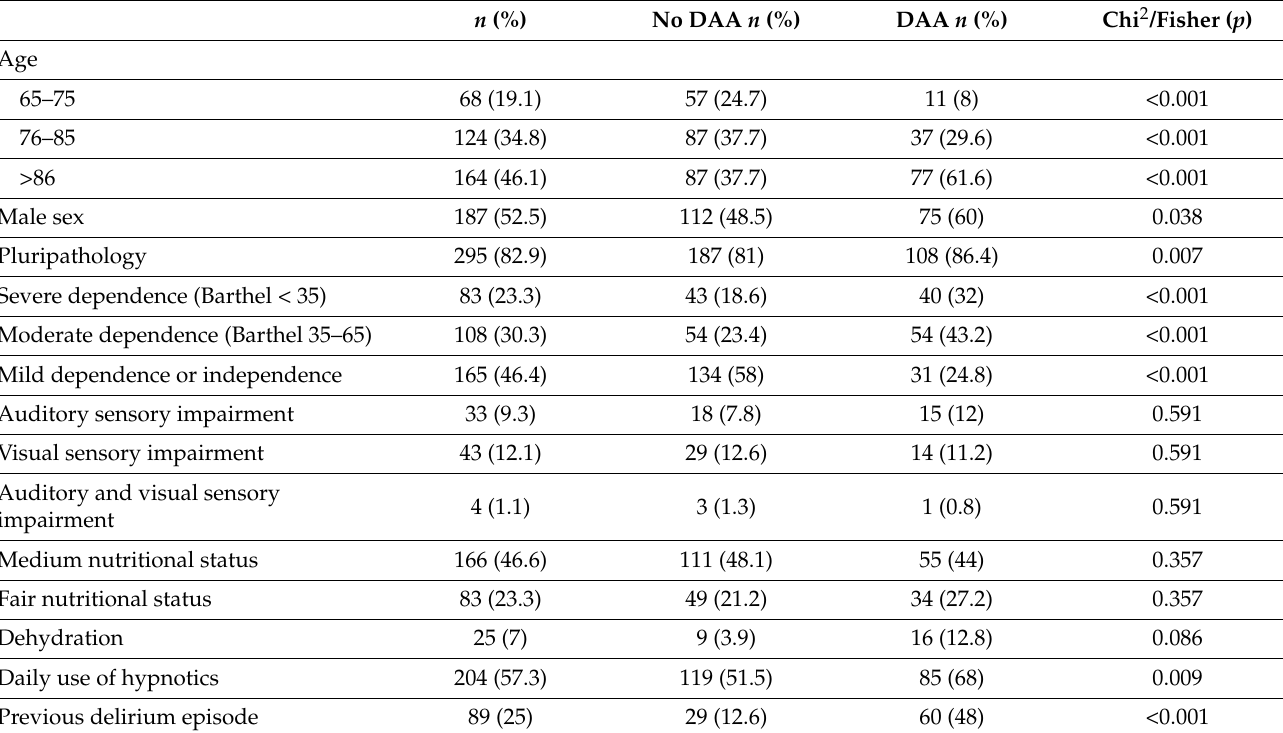
Table 2. The relationship of the predisposing factors between the total sample compared to the cohorts that presented with ADE and those that did